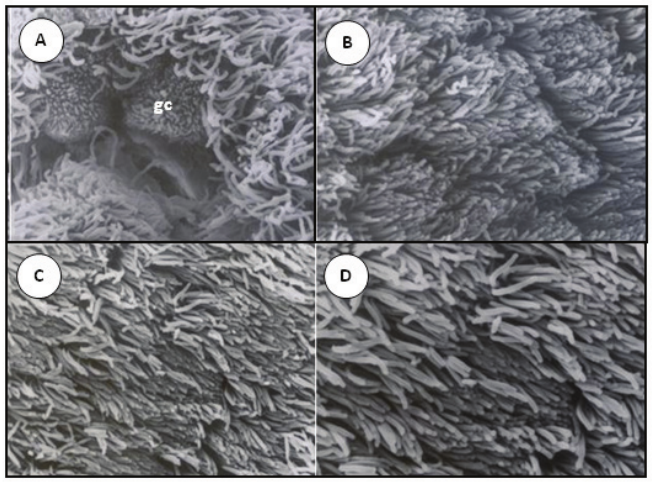
FIGuRE 4 - Control dog. Distal trachea. Scanning electron microscopy showing goblet cells ( gc ) lie between ciliated cells ( A , x 4,820), and abundance of the ciliated cells and normal cilia structure ( B – x 4,055, C – x 4,630 and d – x 6,840).